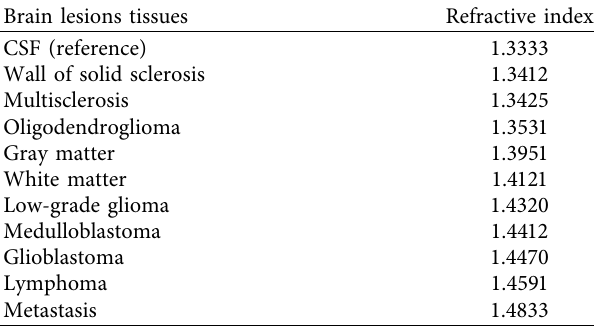
Table 2: The refractive index of various brain tissues. Brain lesions